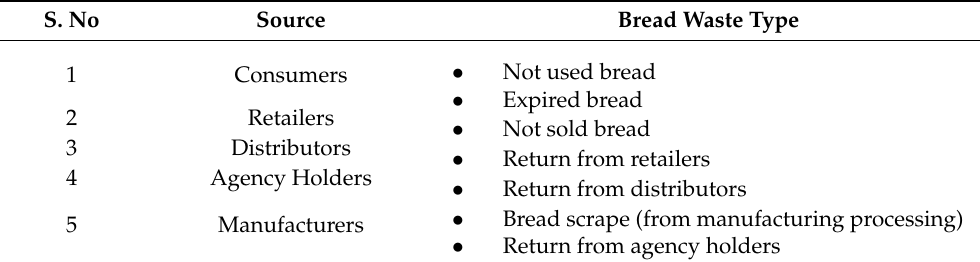
Table 1. Bread waste type and its source.